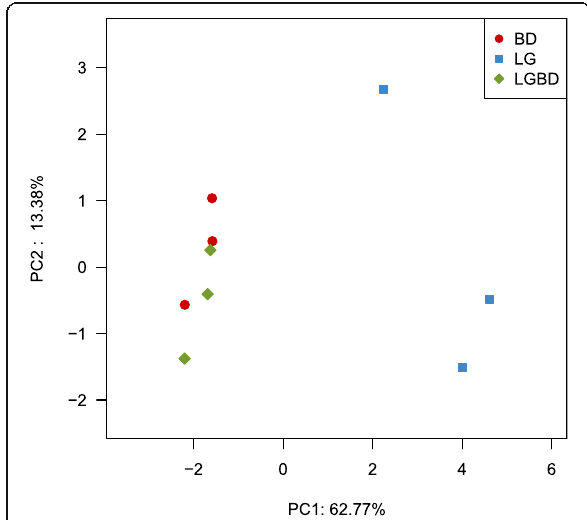
Fig. 4 Principal component analysis of soil carbon source metabolism of the different microbial communities. Note: BD, Betula dahurica ; LG, Larix gmelinii ; LGBD, mixed Larix gmelinii and Betula